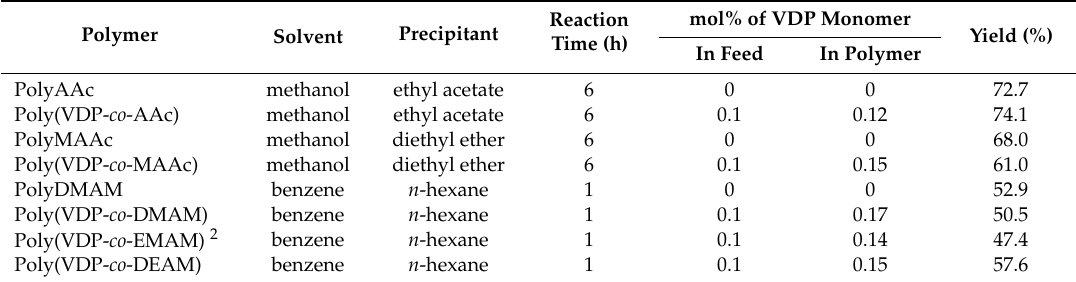
Table 1. Recipes for polymerizations 1